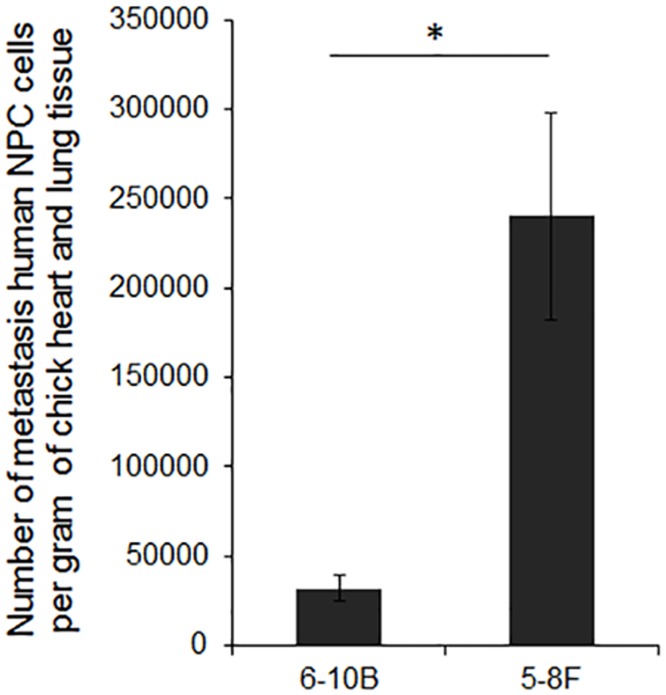
Quantification of disseminating NPC cells in CAM.Number of circulating 5-8F and 6-10B cells in the lung and heart of developing chicken evaluated by β-globin–based qPCR and expressed as mean ± SD (n = 5 for each cell line). * P<0.05.